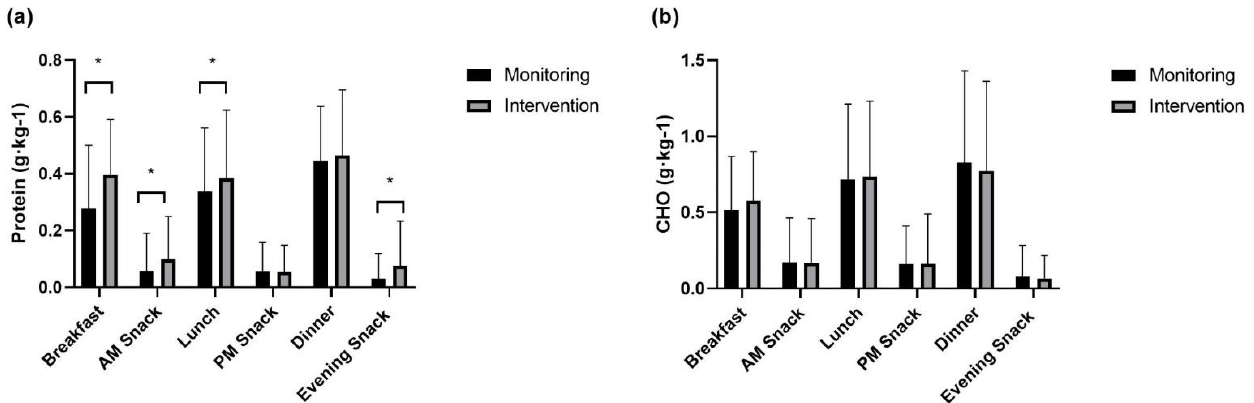
Figure 2. Relative between-meal intake on low-volume training days of ( a ) protein and ( b ) carbohy- drate. * signifies a significant difference in intake between monitoring and intervention periods.